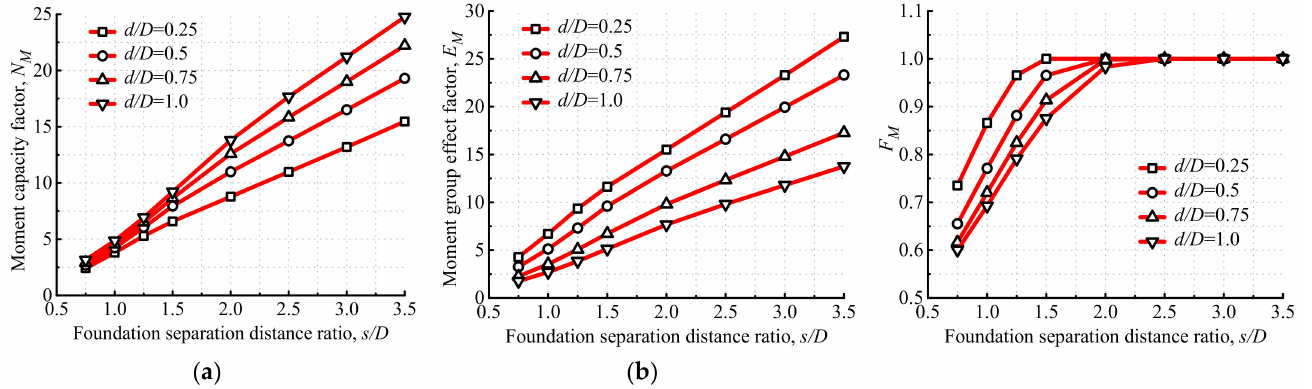
Figure 15. Moment capacities of tetrapod bucket foundations at κ = 10: ( a ) moment capacity factor, ( b ) moment group effect factor and ( c ) normalized moment group effect factor. Take ϕ = 0 as an example: the vector fields of the displacement of the single bucket foundation and tetrapod bucket foundations under ultimate moment loading at κ = 10 when d/D = 0.25 and 1.0 are presented in Figure 16. When s/D =0.75, the tetrapod bucket